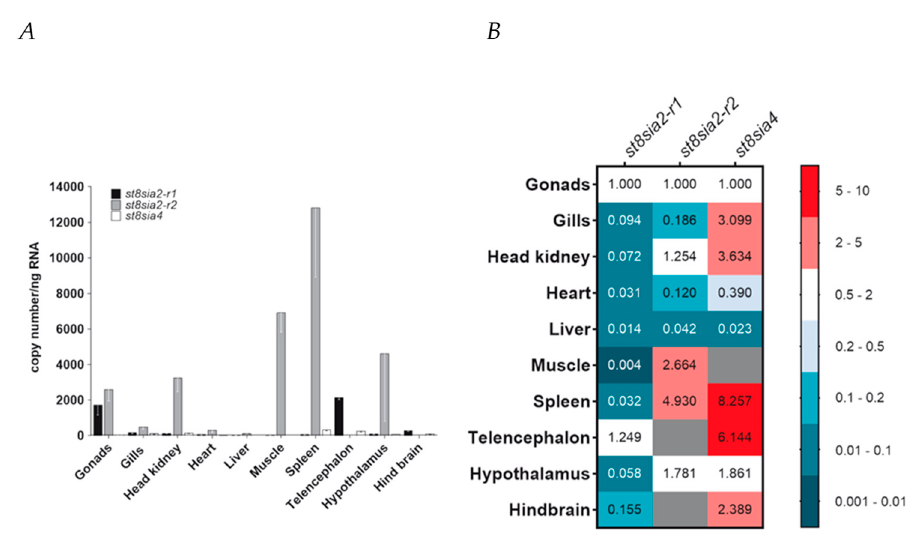
Figure 9. Expression profiling of poly- α 2,8-sialyltransferase-encoding genes in maraena whitefish. ( A ) Transcript levels of st8sia2-r1 (black bars), st8sia2-r2 (gray), and st8sia4 (blank) were determined in ten tissues from maraena whitefish ( n = 4), as indicated on the abscissa. Bars represent the averaged copy numbers normalized against three reference genes; error bars represent the standard deviation. ( B ) A heat map represents the same copy numbers per target gene as shown in ( A ) relative to the expression in gonads (set as 1.0). These relative expression values are colored according to the code given at the right. Non-detectable transcript numbers are indicated by gray fields.